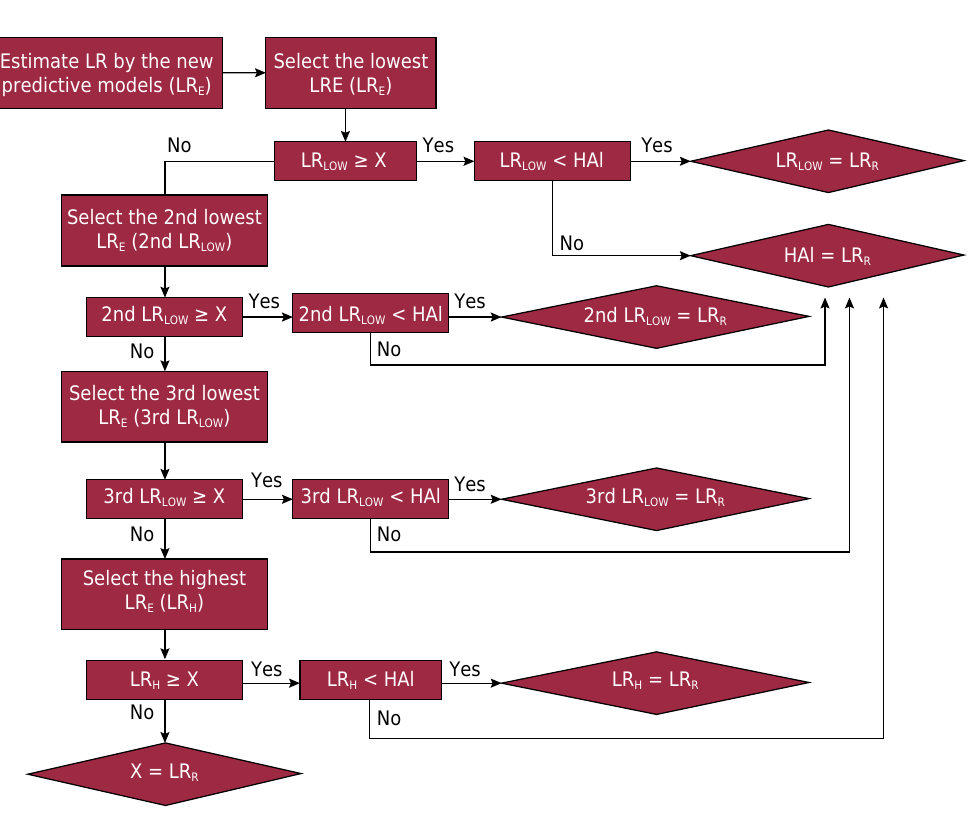
Figure 2. Flowchart of the proposed algorithm to select which estimated lime requirement (LR E , t ha -1 ) by the new predictive models should be recommended (LR R ). X, crop nutrient requirements for Ca 2+ and Mg 2+ ; HAl, soil potential acidity, both in cmol c dm -3